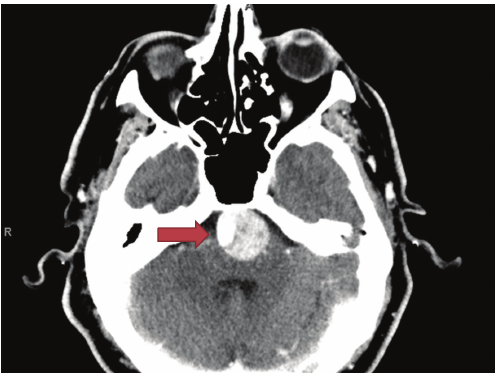
Figure 3: Head CTA: There is a very large aneurysm of the basilar artery measuring 25mm in diameter, which shows a large amount of thrombus within it. The right lateral aspect of the thrombus remains canalized, extending into the basilar tip. There is associated mass e ff ect on the medulla and pons. There is no evidence of aneu- rysm rupture.